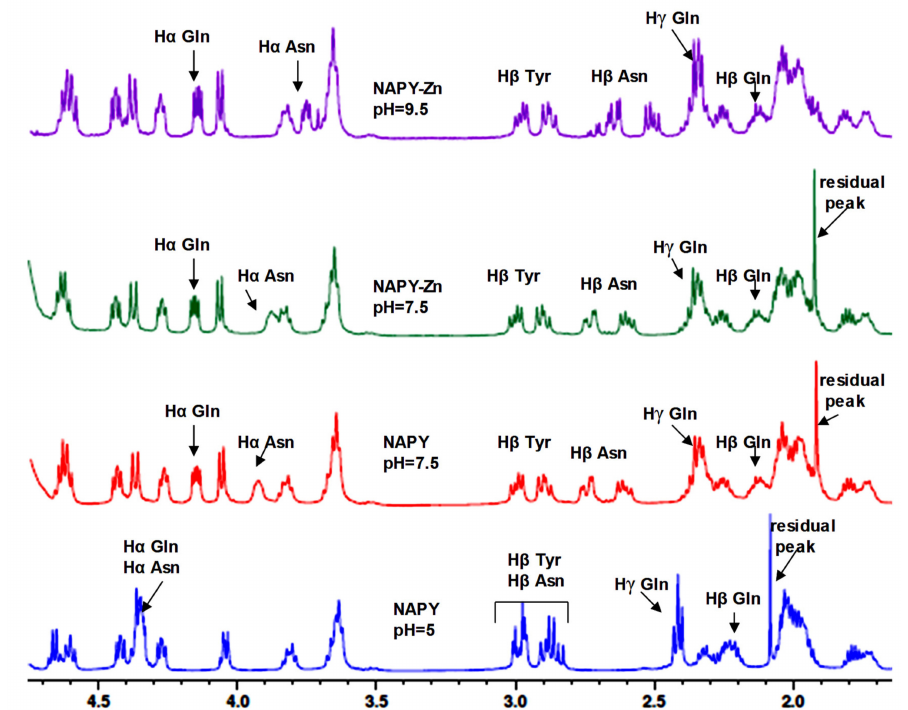
Figure 9. 1 H-NMR spectra of NAPY peptide titrated with of Zn 2+ ions at pH 7.5 and pH 9.5, at a 1:10 molar ratio.